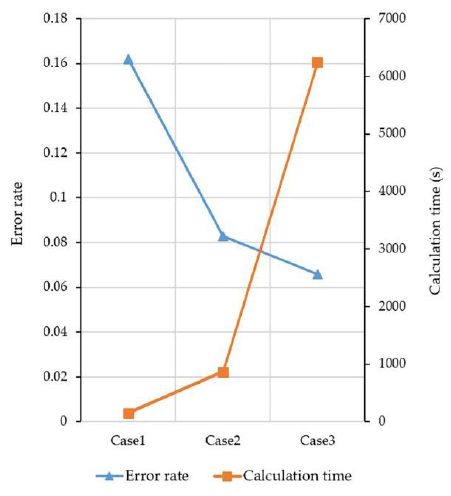
Figure 6. Error values and calculation time.